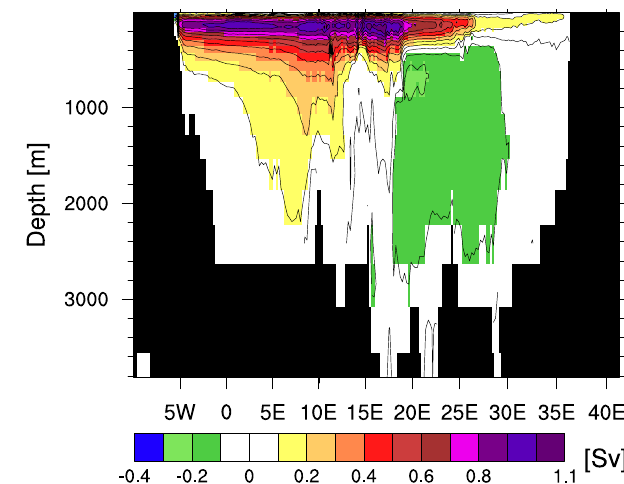
Fig. 4. Zonal overturning stream function integrated over the entire Mediterranean basin for the CTRL experiment. It has been calcu- lated on the basis of a 100-yr mean velocity